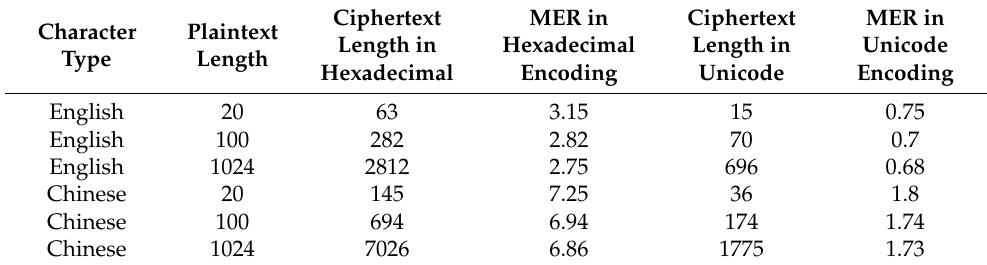
Figure 5. The encryption time with different size of definition domain. Table 3. The results for message